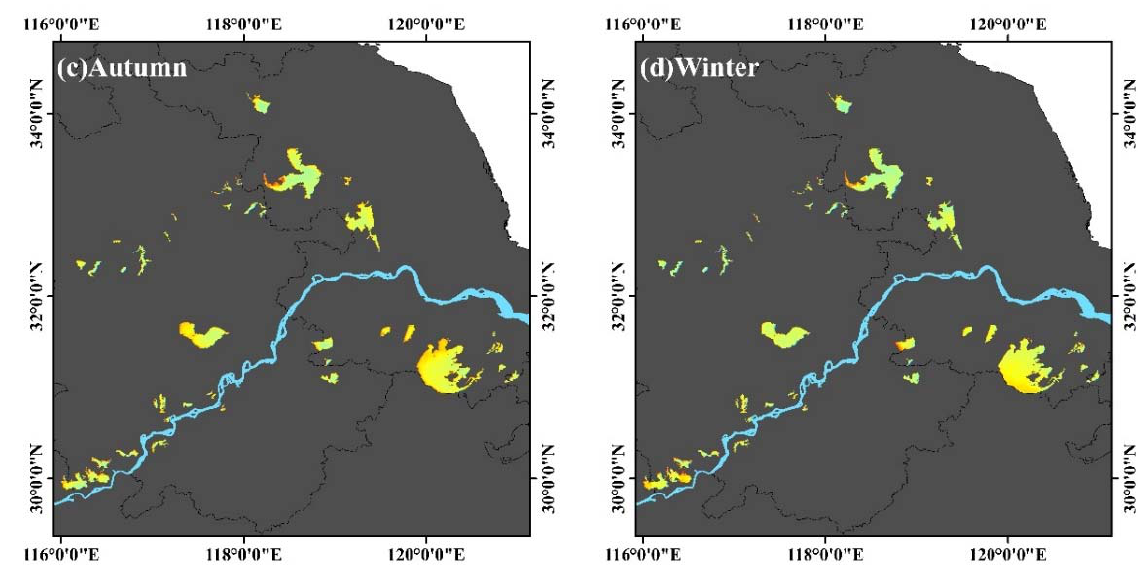
Figure 7. The seasonal distribution pattern of the TSI in the YRD: ( a ) spring, ( b ) summer, ( c ) autumn, and ( d ) winter. To further analyze the spatial differences of lakes in the YRD, the TSI mean value of